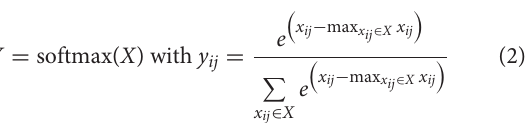
However, such a methodology is limited by the number of available vector registers on each